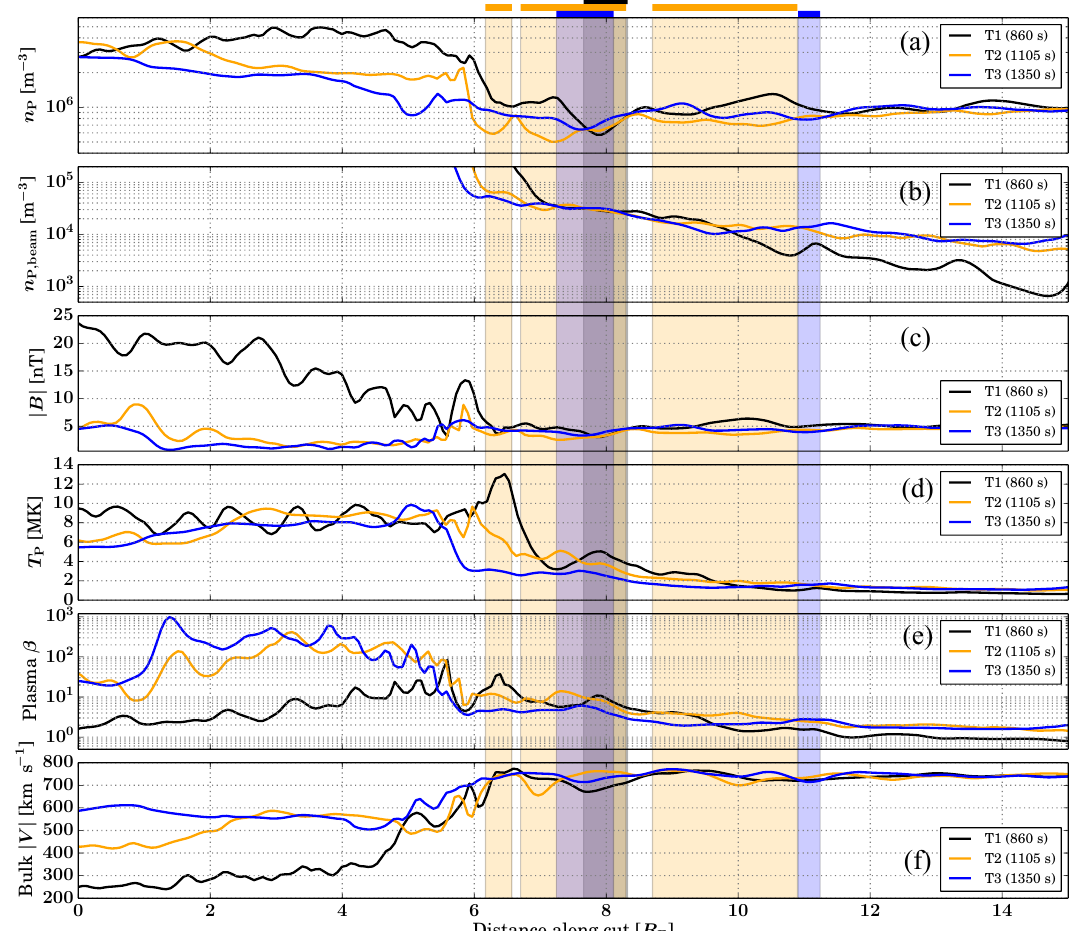
Figure 3. Profile cuts from the magnetosheath across the shock into the foreshock region at three different times of the simulation. The locations of the cuts were shown in Fig. 2. Rectangular areas shaded in grey, yellow, and blue indicate the regions at each time ( T 1 , T 2 , and T 3 , respectively), which fulfill our caviton criteria of n P < 0 . 8 n P, sw and | B | < 0 . 8 | B SW | . Each shaded area is accompanied by a indicator bar above panel (a) . The beam density n P, beam is not well defined in the sheath and is thus allowed to